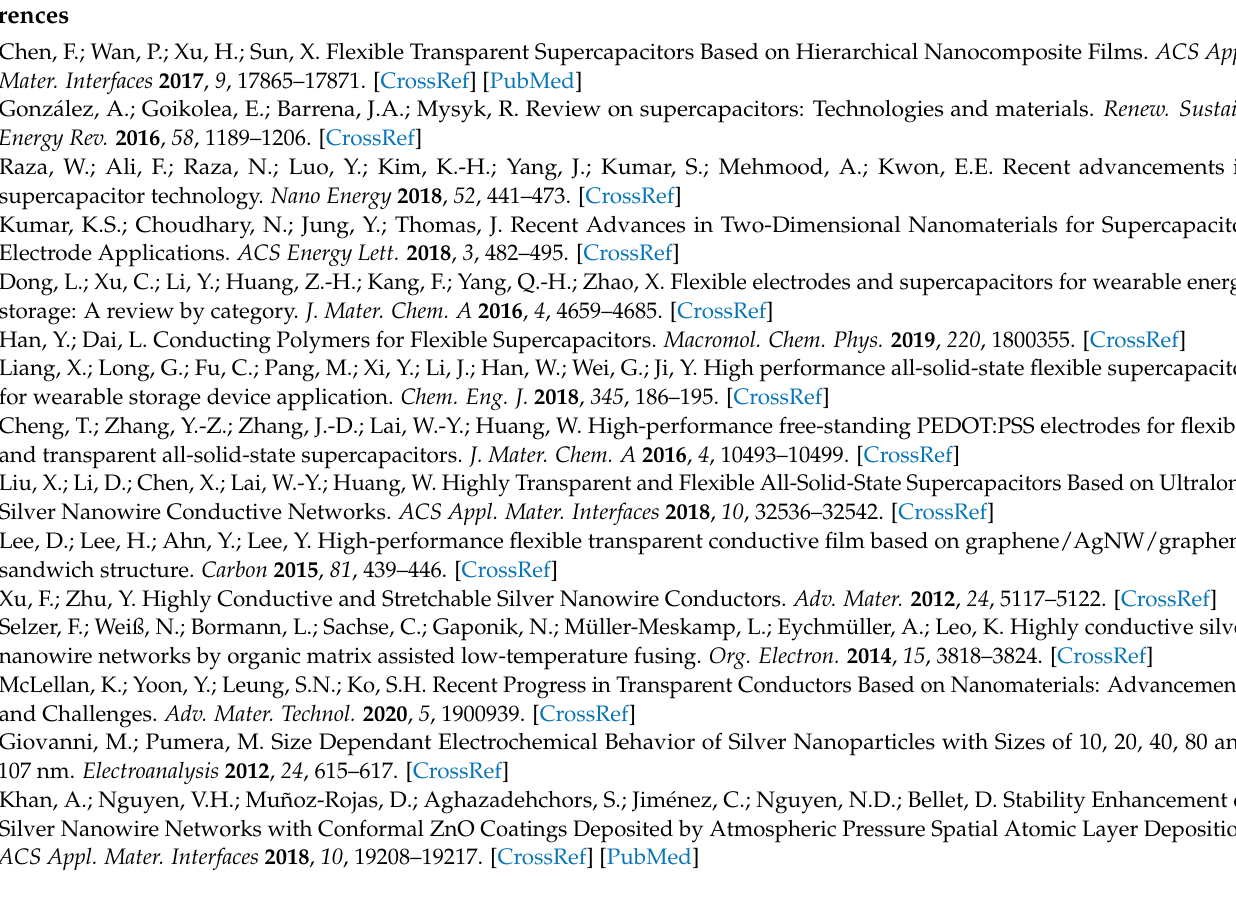
images of the AACS NWs; Figure S4. (a) TEM image of the pristine Ag NW. (b) TEM-EDX line profile of the pristine Ag NW. (c) TEM image of the AACS NW. (d) TEM-EDX line profile of the AACS NW; Figure S5. The result of the repeated bending test of the Ag NW and AACS NW network electrode; Figure S6. (a) Comparison of the electrical resistance of the electrodes before, and after the electroplating process. (b) Light transmittance of the Ag NW and AACS NW before, and after 1min electroplating. (c) Digital image of the Ag NW, AACS NW and Ag/Au/MnO 2 NW electrodes. (d) CV curves of the electrodes after the electroplating of the MnO 2 ; Figure S7. XRD spectrum of the Ag/Au/MnO 2 electrode; Figure S8. (a) Dependence of the current density on the deposition time during electroplating process. (b) The estimated weight of the electrodeposited MnO 2 and the deposition rate as functions of the deposition time; Figure S9. (a) CV curves of the AACS NW electrode obtained with various scan rate. (b) Log plot between CV currents (at 0.4 V) and scan rates, based on the relationship of i = av b ; Figure S10. (a) The bending test result for the Ag/Au/MnO 2 electrode as a half-cell supercapacitor. (b) The result of the same bending test for the all solid-state supercapacitor fabricated with a pair of Ag/Au/MnO 2